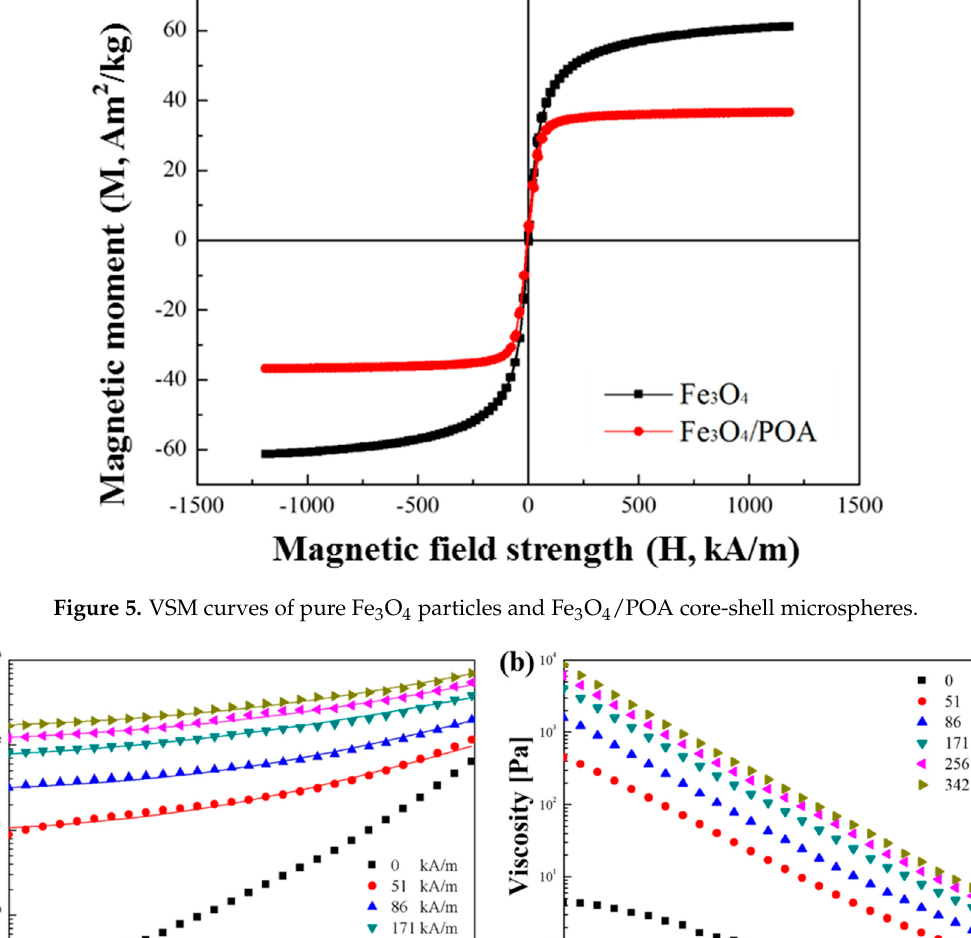
Figure 4. FT-IR absorption spectra of (a) POA, (b) Fe 3 O 4 / POA, and (c) Fe 3 O 4.